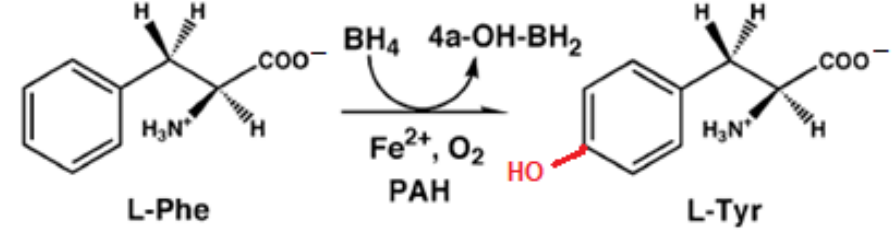
Scheme 1. PAH-catalyzed reaction.